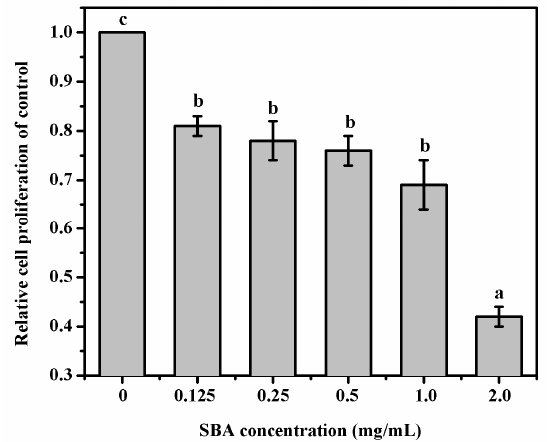
Figure 1. Effects of SBA on IPEC-J2 proliferation. Cell proliferation was measured by MTT assay at 6 concentrations points (0, 0.125, 0.25, 0.5, 1.0, or 2.0 mg/mL) for 24 h. Absorbance was measured at 570 nm. Means with different superscript are significantly different in compare with its control. Data are represented as mean ± standard error of mean (SEM) ( n = 3).